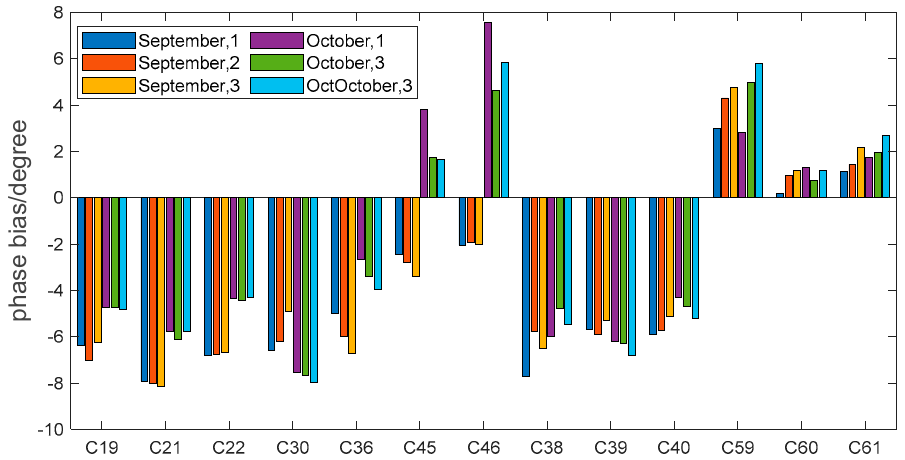
Figure 16. Carrier phase bias between B2ap and B2bp signal in 2022.